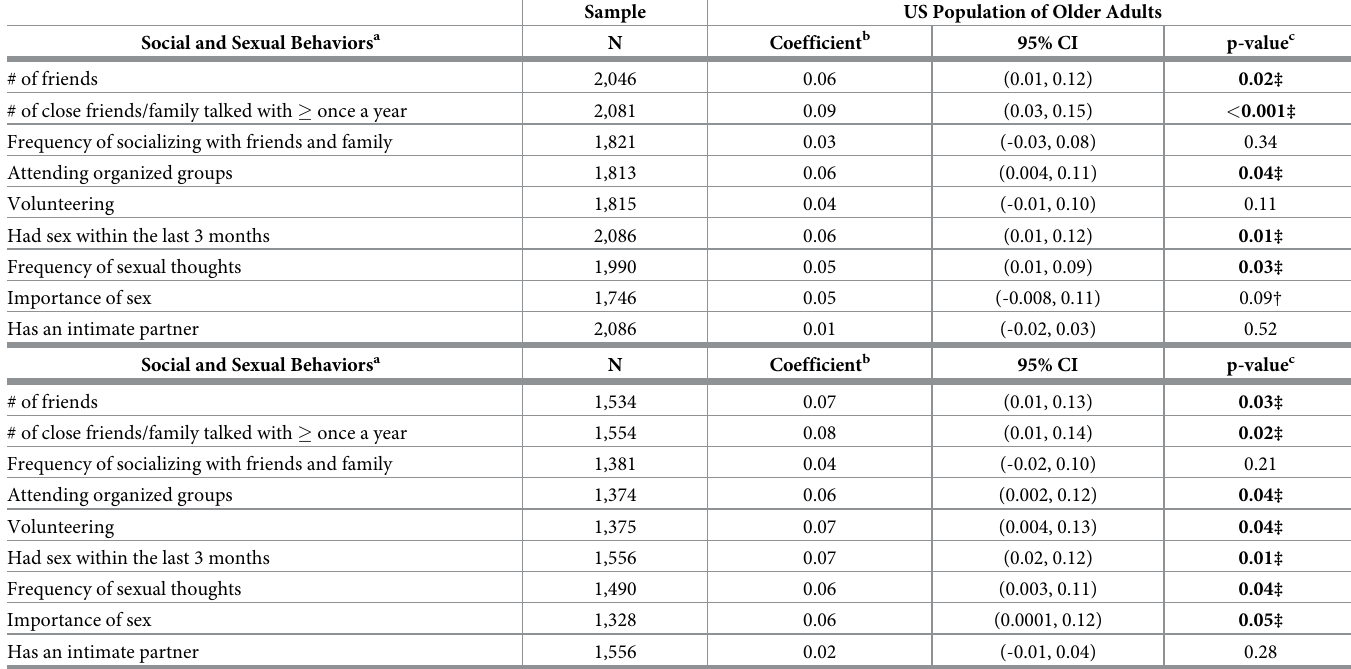
Table 3. Associations between androstadienone sensitivity and social and sexual behaviors of older US adults living at home. A . B . Normosmic US older adults living at home: Associations between androstadienone sensitivity and social and sexual behaviors. (NB Tables are large and at the end of the manuscript). Sample US Population of Older